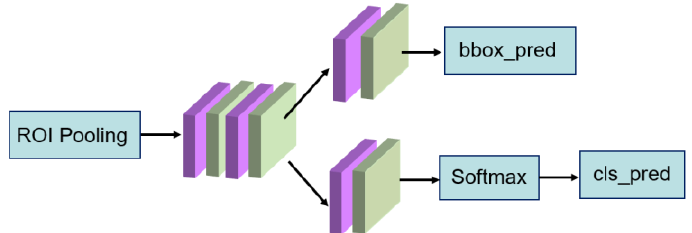
Figure 3. The framework of the re-regression and re-classification network.